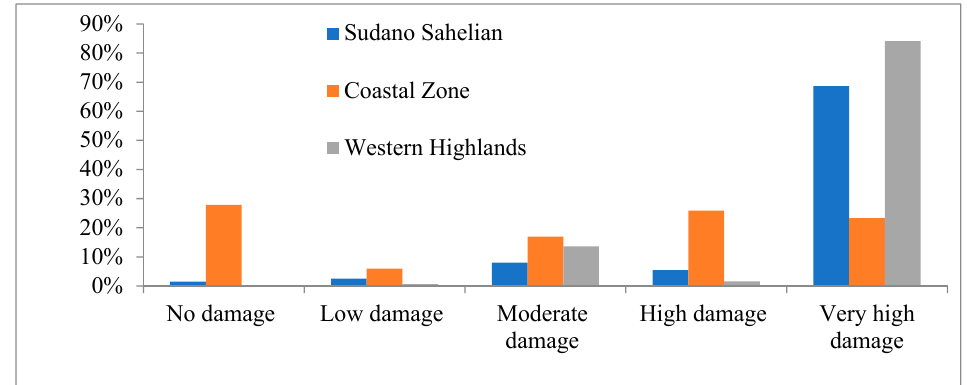
Figure 4. Level of flood damage to households, percentage of household heads.